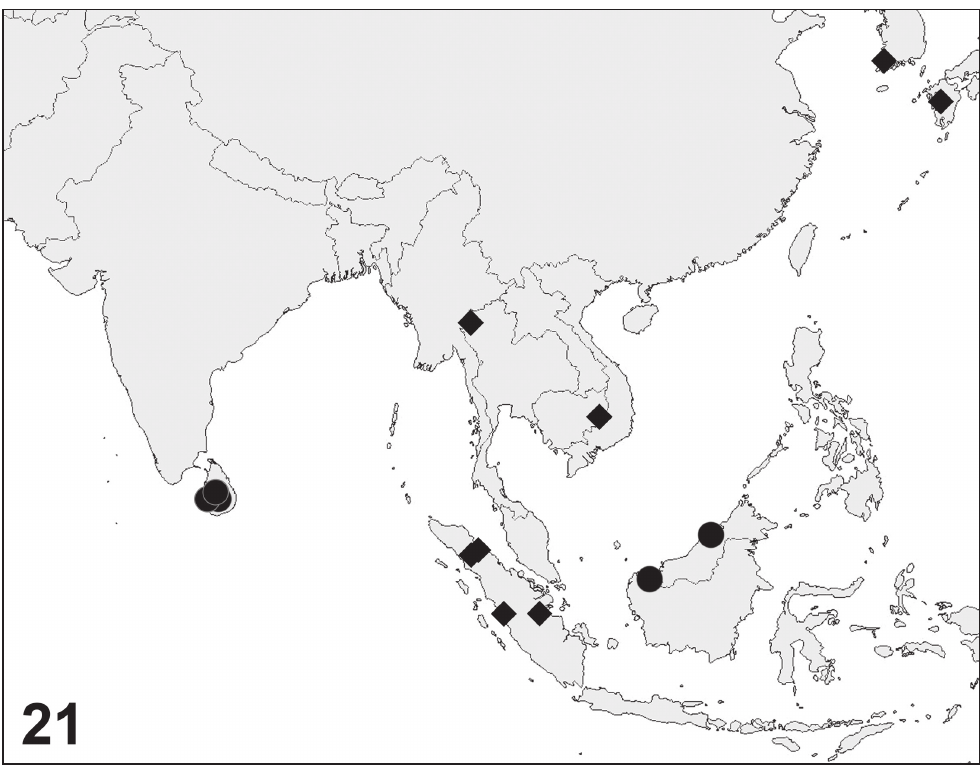
Figure 21. Distribution of N. ineffectalis . Previous records marked with dots, new records with longer than diameter of eye (longer than in male, see Figs 13–15); 3rd segment conspicuous, 2nd segment broad, domed. Scale-hood of vertex broad-based and long. Forewing brownish grey in colour; subterminal and postmedial lines parallel, slightly sinuous, the subterminal easily fading during ageing, the latter relatively broad; reniform stigma quite small, angular, elongated, pale yellow with two black dots inside, lower dot is larger than the upper one; orbicular rounded, as yellow as reniform. Hindwing slightly paler than forewing except for the area between vein Cu2 and dorsum being as dark as forewing; transverse lines like those of forewing but postmedial line often more conspicuous. Pattern of wings slightly less conspicuous in females than in males. Female genitalia (Fig. 19). Corpus bursae ovoid, its anterior half densely covered by tiny grains, posterior half slightly wrinkled in longitudinal direction. Near the mouth of ductus bursae a broad and long, helical cervix arises. Ductus bursae smooth, broad, relatively short, nearly entirely cov - ered by the triangular colliculum. Sternum A7 very narrow, sinus absent.